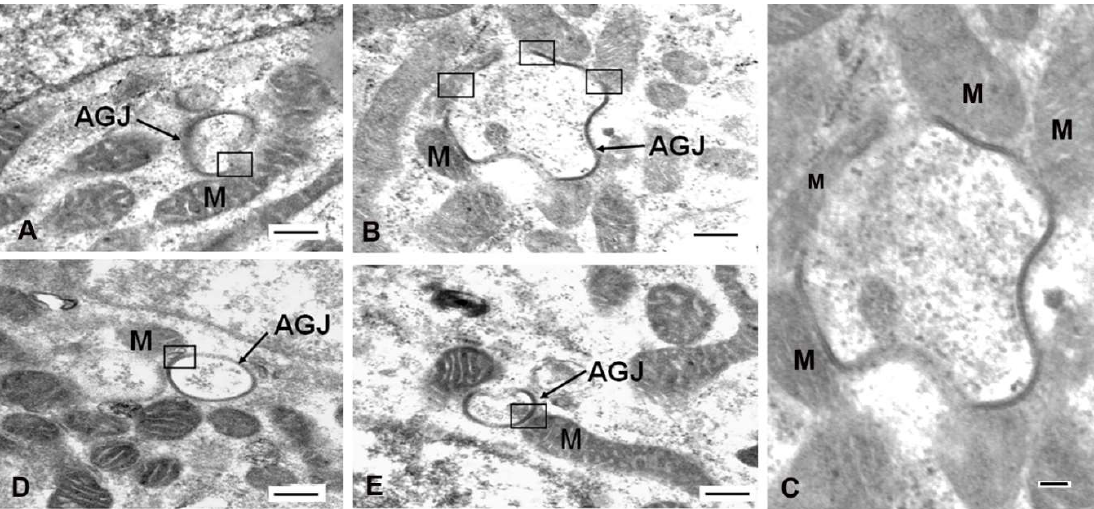
Figure 5. Transmission electron microscopy of mitochondria closely associated with annular gap junctions. ( A – E ) Areas of contact between annular gap junctions (AGJ) and mitochondria (M) are indicated within the black boxes ( A , B , D , E ). ( C ) The annular gap junction vesicle seen in ( B ), but imaged at a different section plane, is enlarged to better show the contact areas. Scale Bars: 500 nm.